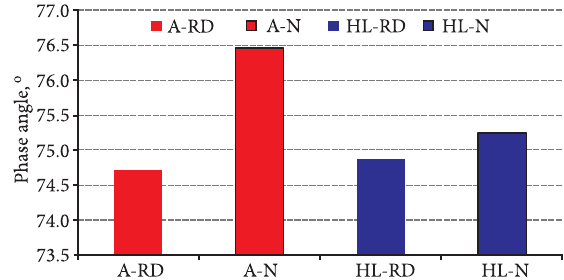
Fig. 6. The phase angle value δ of extracted bitumen at frequency of 1.56 Hz and temperature of 60